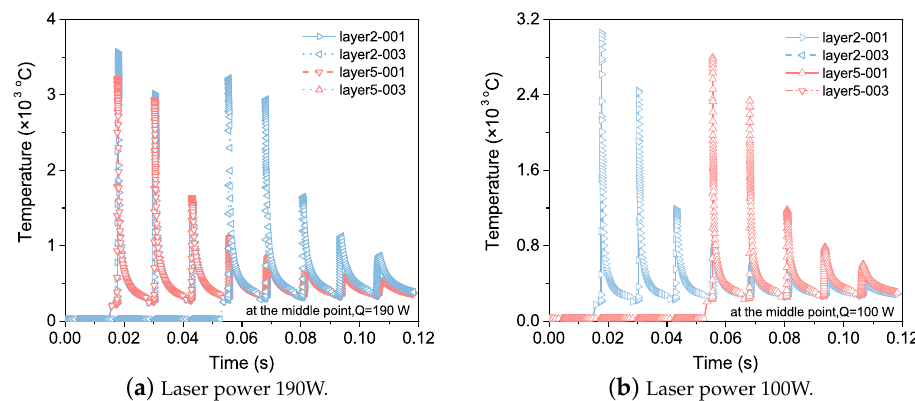
Figure 15. Temperature evolution at the center of the 2nd and 5th layers under different grid sizes.